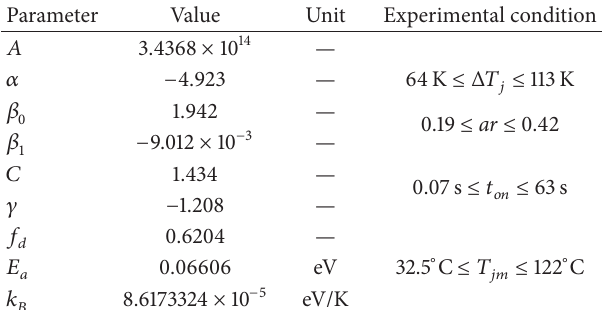
Table 3: Parameters of the lifetime model for power devices [48].